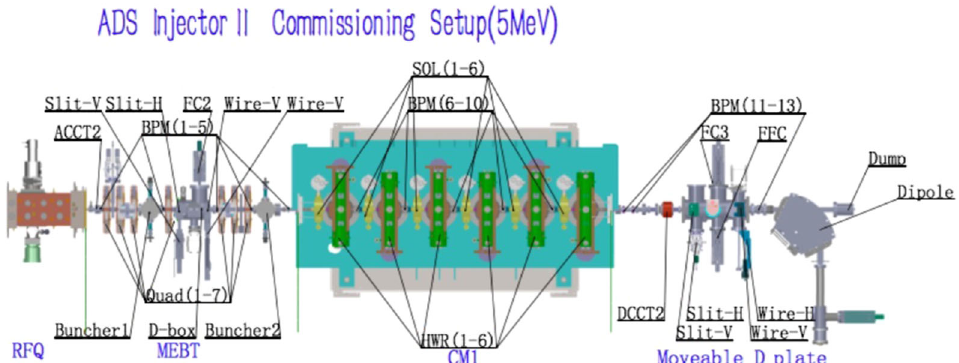
FIG. 16. Layout of the C-ADS injector scheme II with CM6.